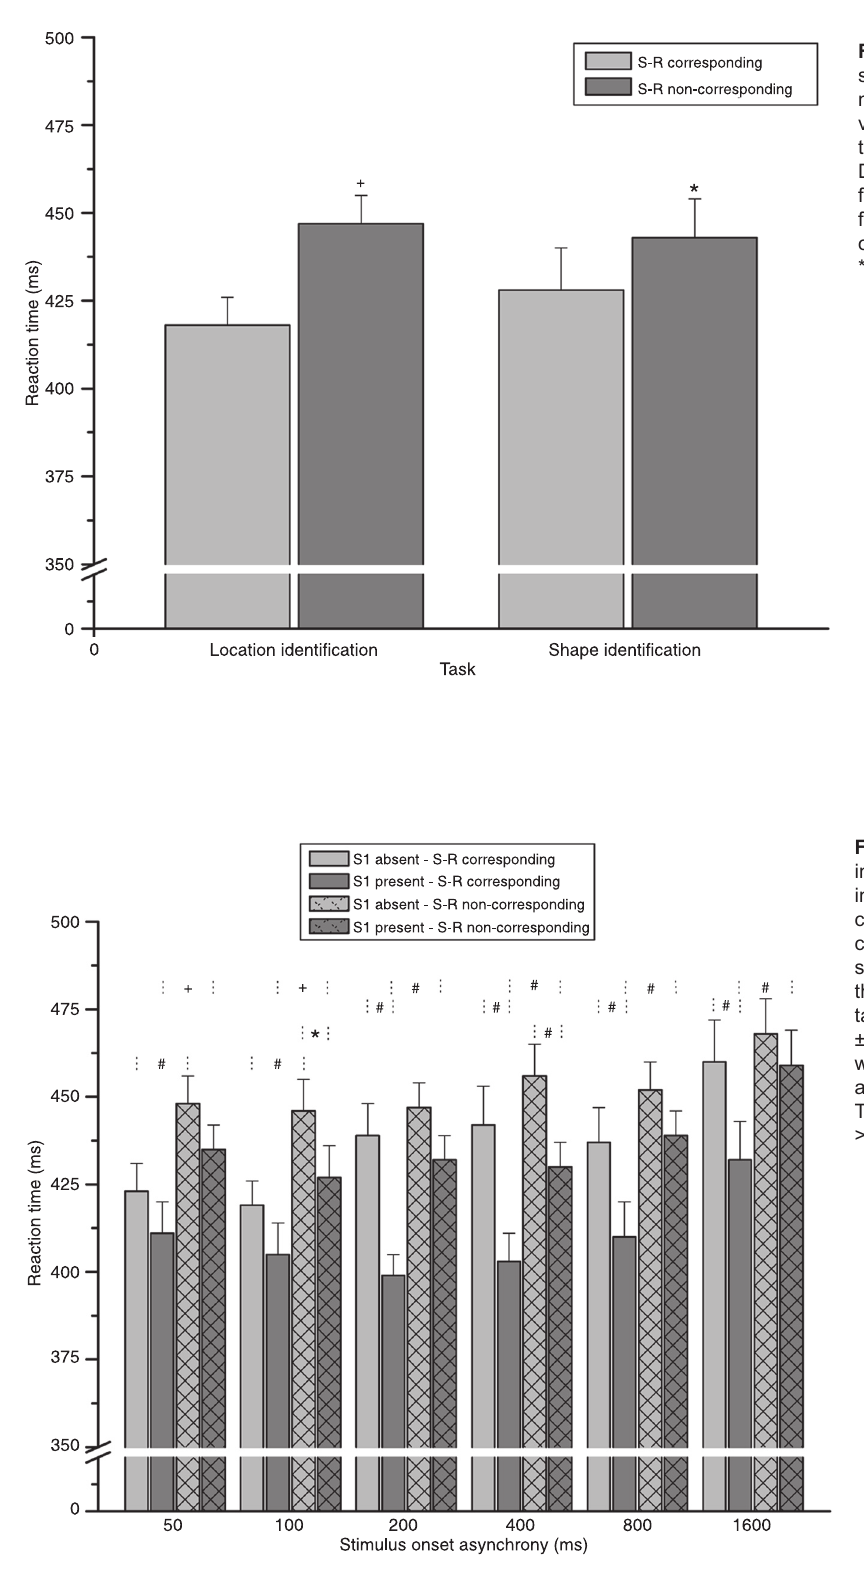
Figure 2. Reaction time in stimulus-re- sponse (S-R) side corresponding and non-corresponding conditions for the visual location identification task and the visual shape identification task. Data are reported as means ± SEM for 12 subjects. Data analysis was per - formed by repeated measures analysis of variance followed by the Tukey test. *P = 0.004; + P < 0.001.